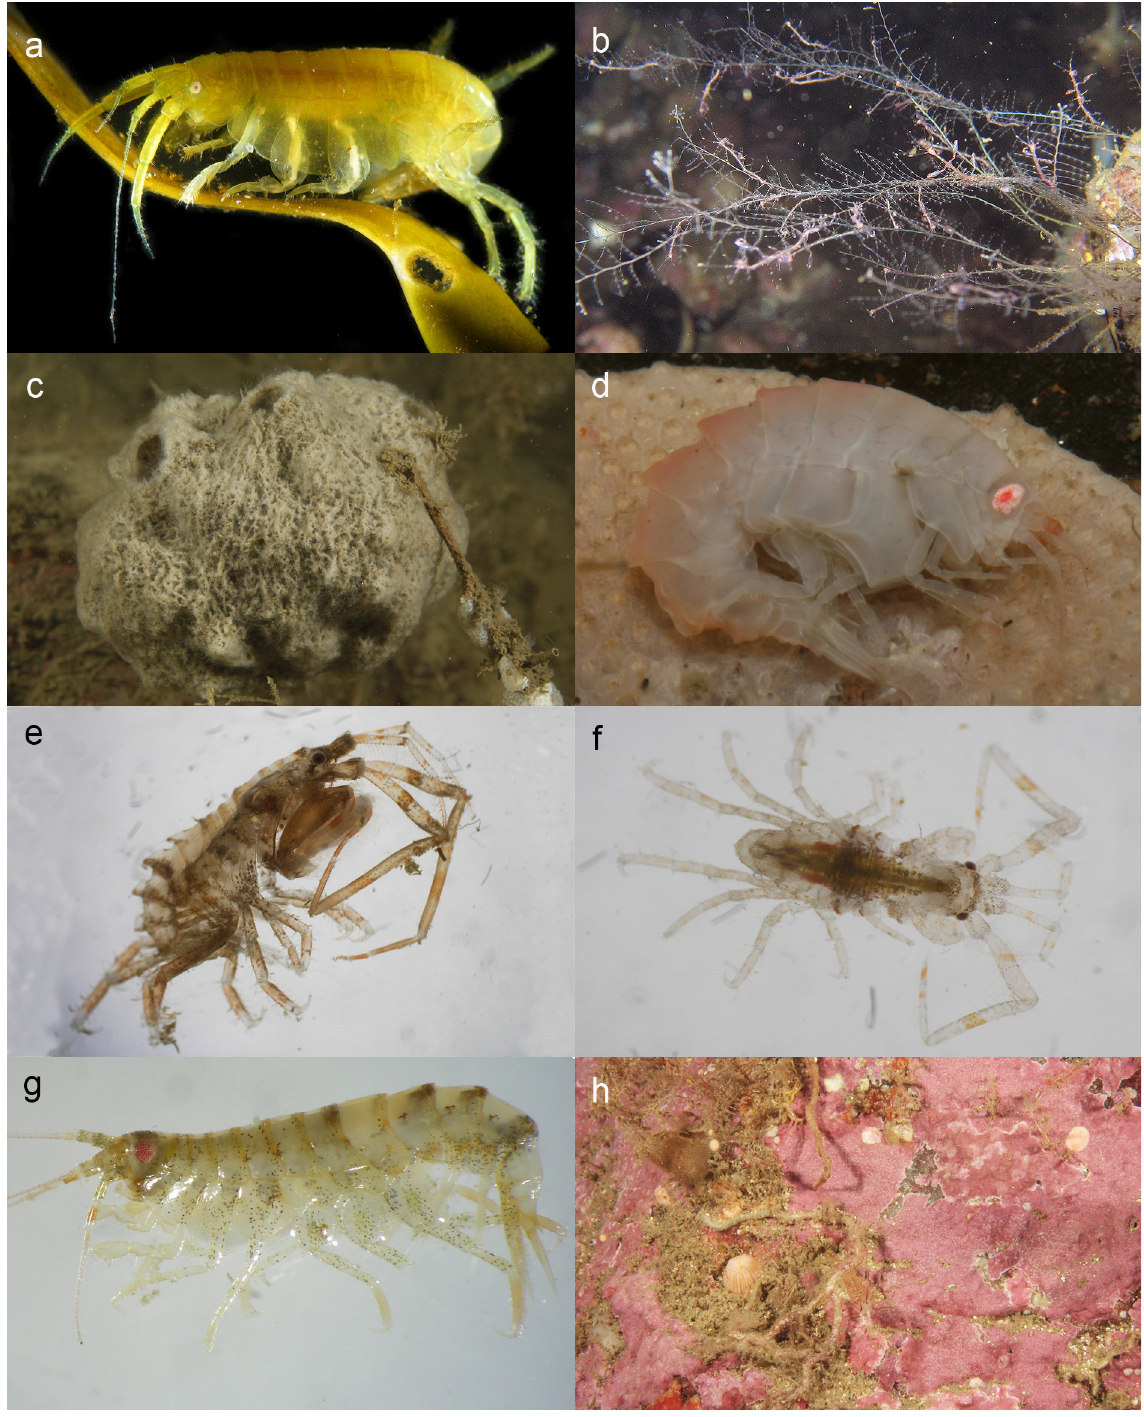
Fig. 30. In vivo photos of some of the described amphipods. a . Sunamphitoe femorata (Krøyer, 1845). b . Numerous specimens of C aprella cf. e quilibra Say, 1818, on the hydrozoan Halopteris schucherti Galea, 2006. c . Habitat of Leucothoe kawesqari Esquete & Aldea, 2015, on sponge. d . Epimeria